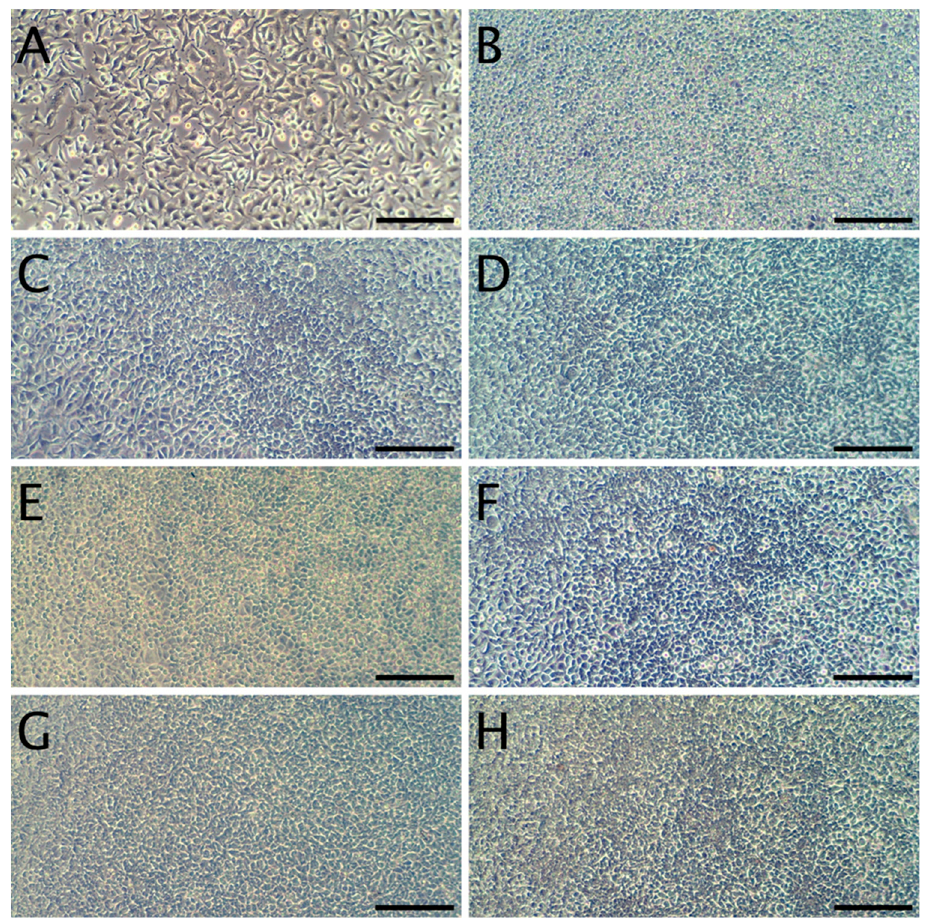
Figure 6. Representative micrographs of L929 fibroblasts. Panel ( A ): Cells 24 h after seeding, but prior to the addition of discs. Panel ( B ): cells incubated for 24 h without disc. Panels ( C , E , G ) present cells beneath WPC discs (WPC; WPC-0.1% and WPC-0.5%) after 24 h of culture. Panels ( D , F , H ) present cells beneath WPI discs (WPI; WPI-0.1% and WPI-0.5%) after 24 h of culture. The scale bar represents 200 μ m.